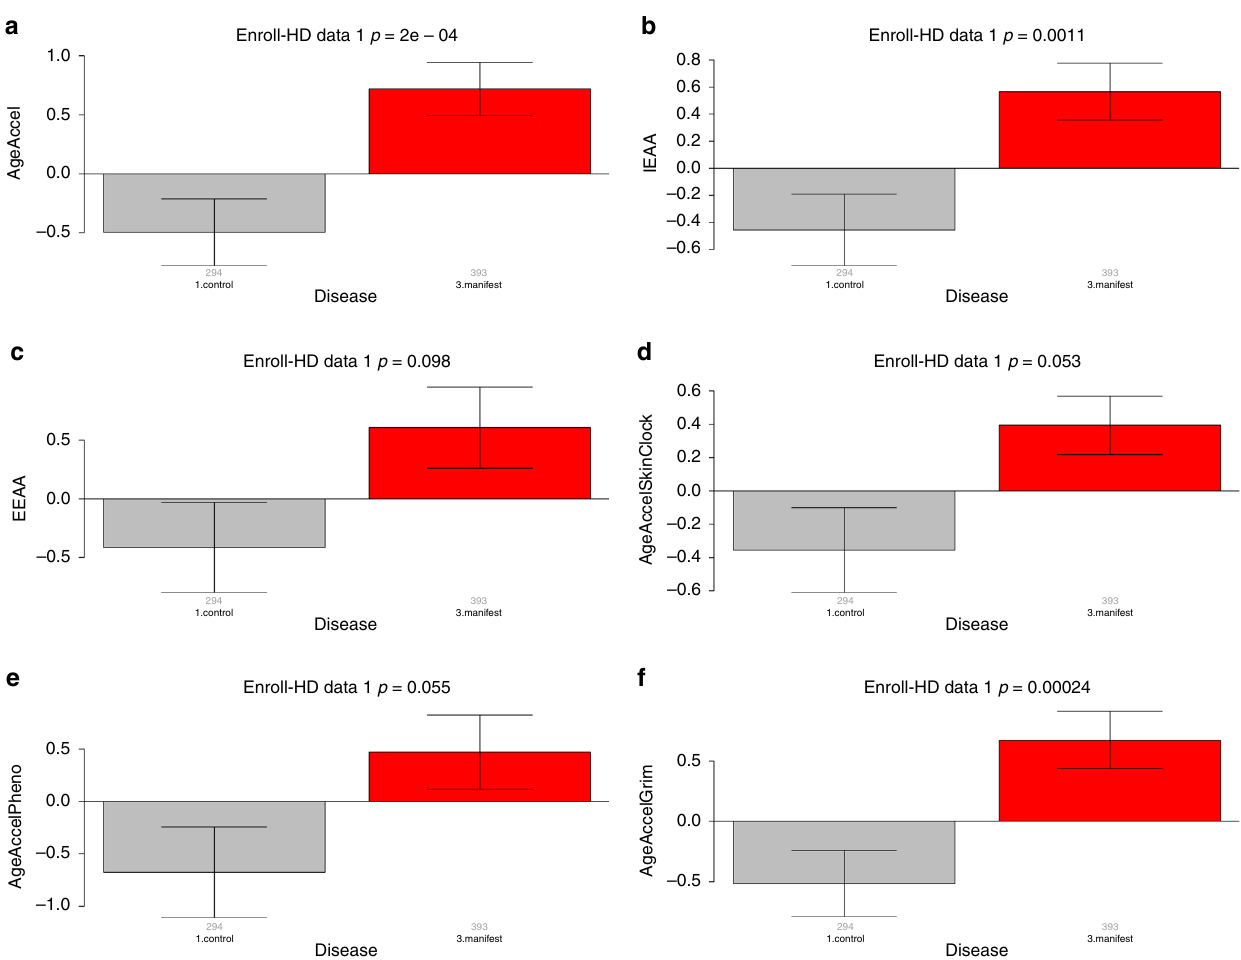
Fig. 3 Epigenetic age acceleration in blood versus manifest HD disease status. Epigenetic age acceleration ( y -axis) versus manifest HD status in N = 687 (294 controls and 393 manifest HD) blood samples from Enroll-HD data 1. Each panel corresponds to a different epigenetic clock. a Age-adjusted DNAm age based on Horvath ’ s pan-tissue clock (AgeAccelerationResidual [AgeAccel]) 14 , b intrinsic epigenetic age acceleration (IEAA), which is independent of blood cell composition, c extrinsic epigenetic age acceleration, which is based on Hannum ’ s clock and does depend on blood cell composition 15 , d age- adjusted DNAm age based on the skin and blood clock (AgeAccelSkinClock) 16 , e age-adjusted DNAm PhenoAge (AgeAccelPheno) 17 , and f age-adjusted DNAm GrimAge 18 (AgeAccelGrim). The title of the bar plots reports the nominal two-sided p value from a Kruskal – Wallis test. The y -axis of the bar plots depicts the mean and one standard error. Group sizes (i.e., number of individuals per disease category) can be found as small gray numbers underneath each